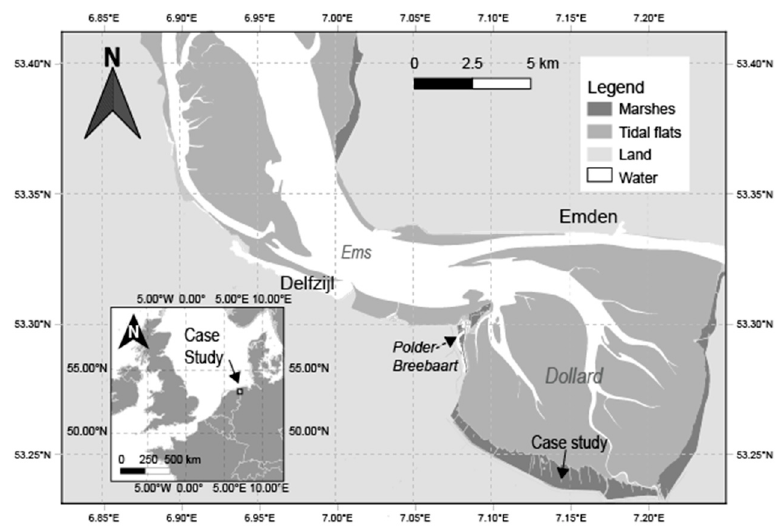
Figure 1. The case-study site in the Dollard within the Dutch Ems estuary. The map was adapted from OpenStreetMap© layers.